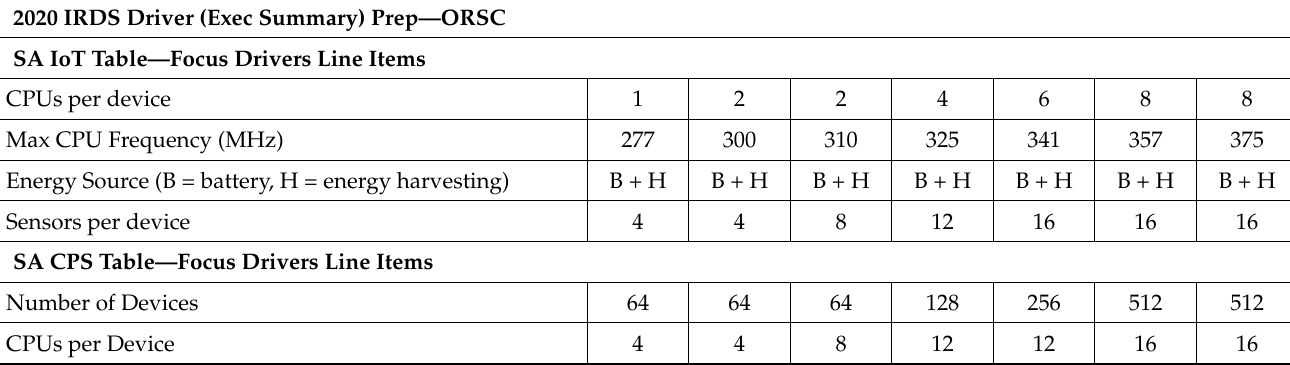
SA IoT Table—Focus Drivers Line Items